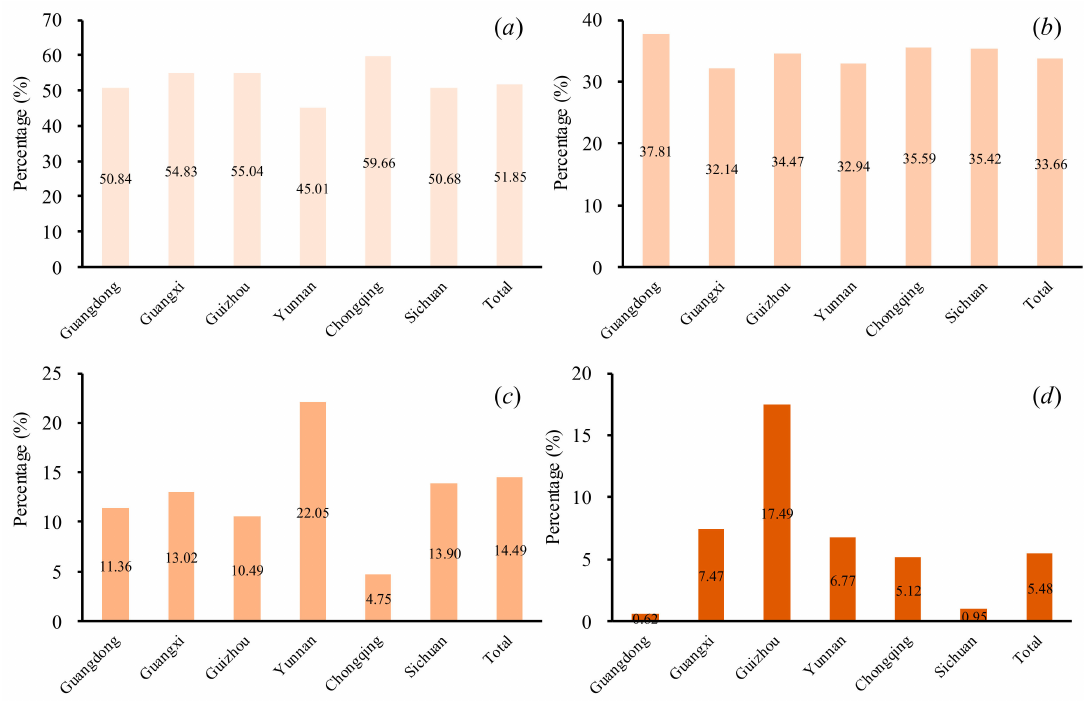
Figure 3. ( a ) The percentage of the total karst rocky desertification areas that have slight karst rocky desertification; ( b ) the percentage the total karst rocky desertification areas that have moderate karst rocky desertification areas; ( c ) the percentage the total karst rocky desertification areas that have severe karst rocky desertification areas; and ( d ) the percentage of the total karst rocky desertification areas in each administrative